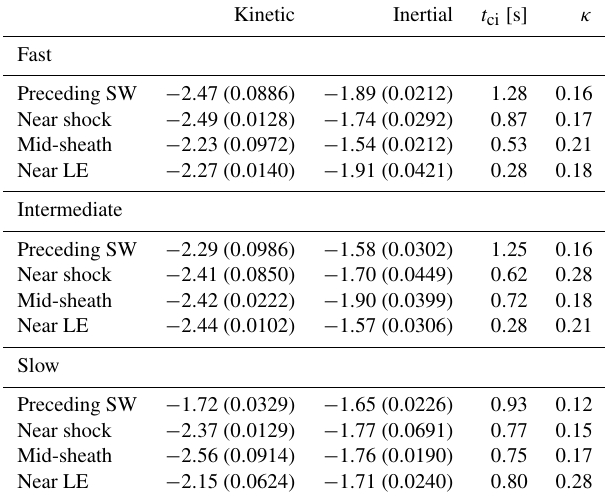
Table 2. Spectral indices as calculated by fitting a straight line in log space for kinetic range ( (cid:49)t = 0 . 092–0 . 37s; three consecutive time lags) and inertial range ( (cid:49)t = 24–96s; five consecutive time lags). The values in the parenthesis show the standard deviation errors associated with the fitting. The third column gives the ion cyclotron period for each region. The last column gives κ = v A /v that tests the validity of the Taylor hypothesis (see Sect. 2 for